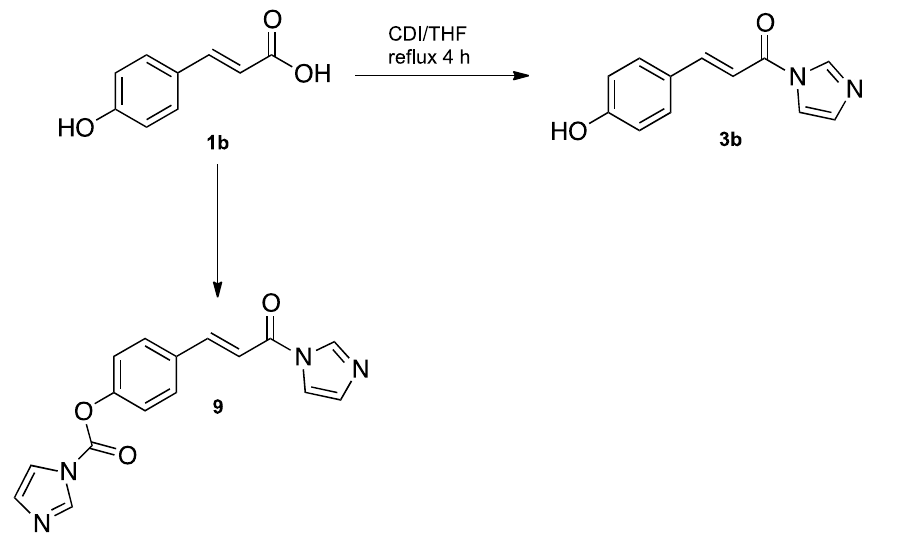
Scheme 2. Synthesis in the condensed phase of p -coumaric-imidazol derivative 3b